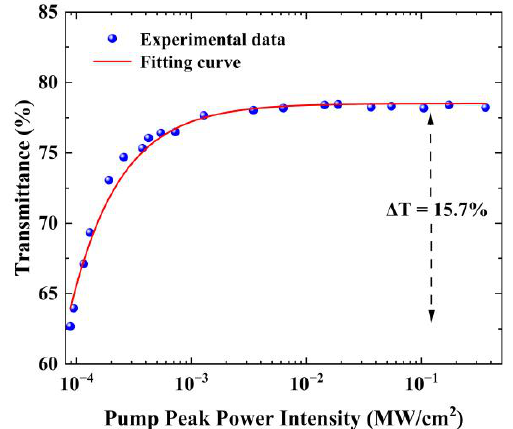
Figure 4. Nonlinear saturable absorption curve of the SNPT-based SA.